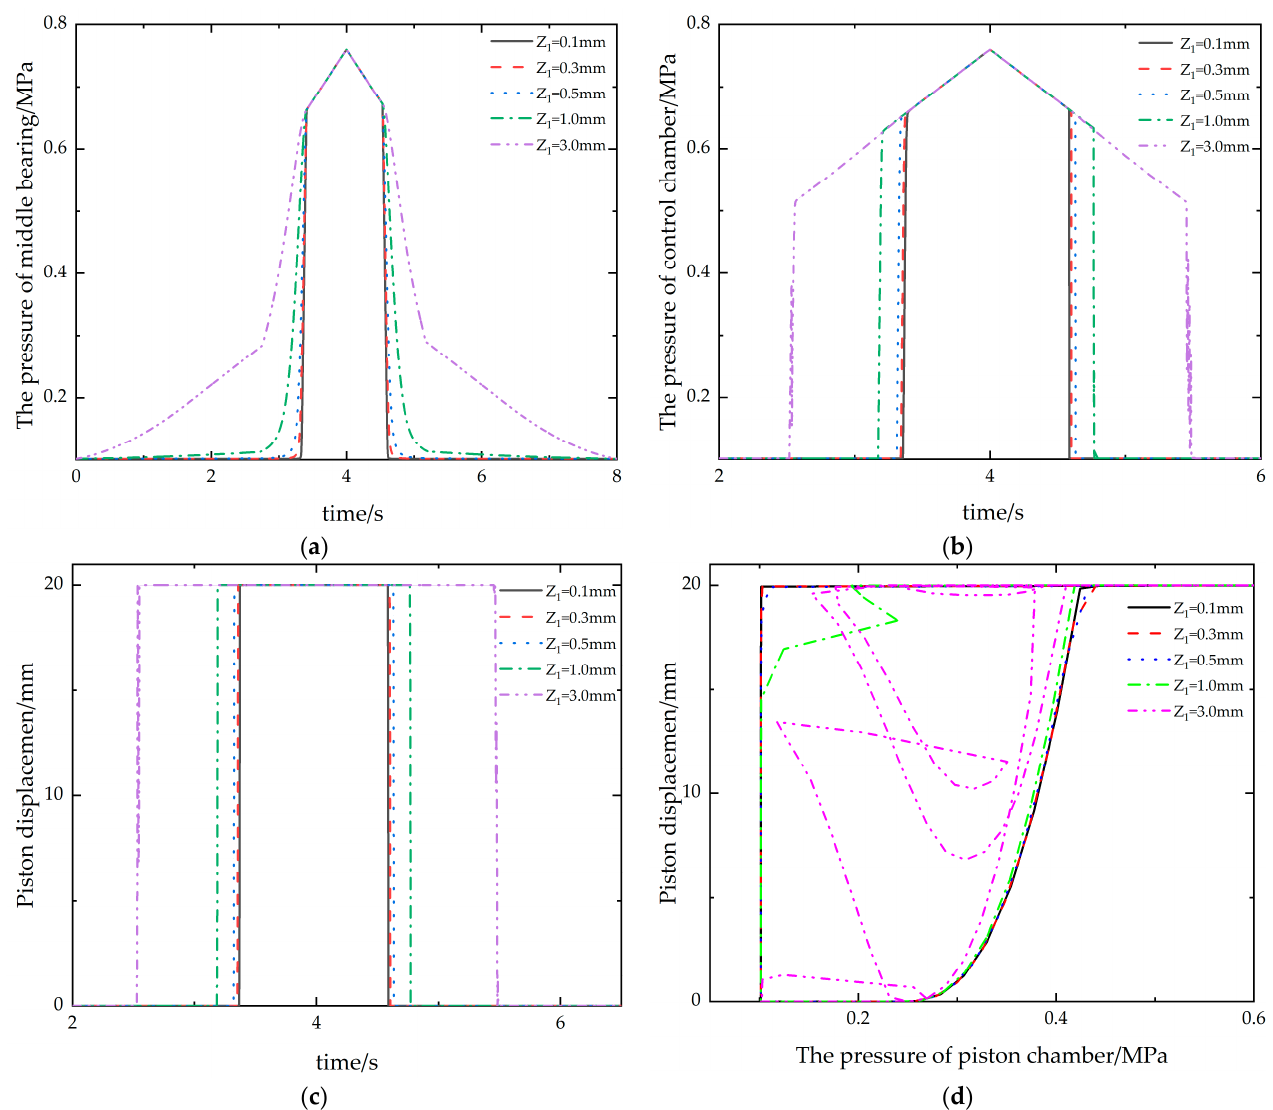
Figure 11. Opening and closing characteristics of valve with different damping hole diameters: ( a ) The variation law of middle bearing pressure with time; ( b ) Control the change of cavity pressure with time; ( c ) The variation law of piston displacement with time; ( d ) The variation of piston displacement with pressure in control